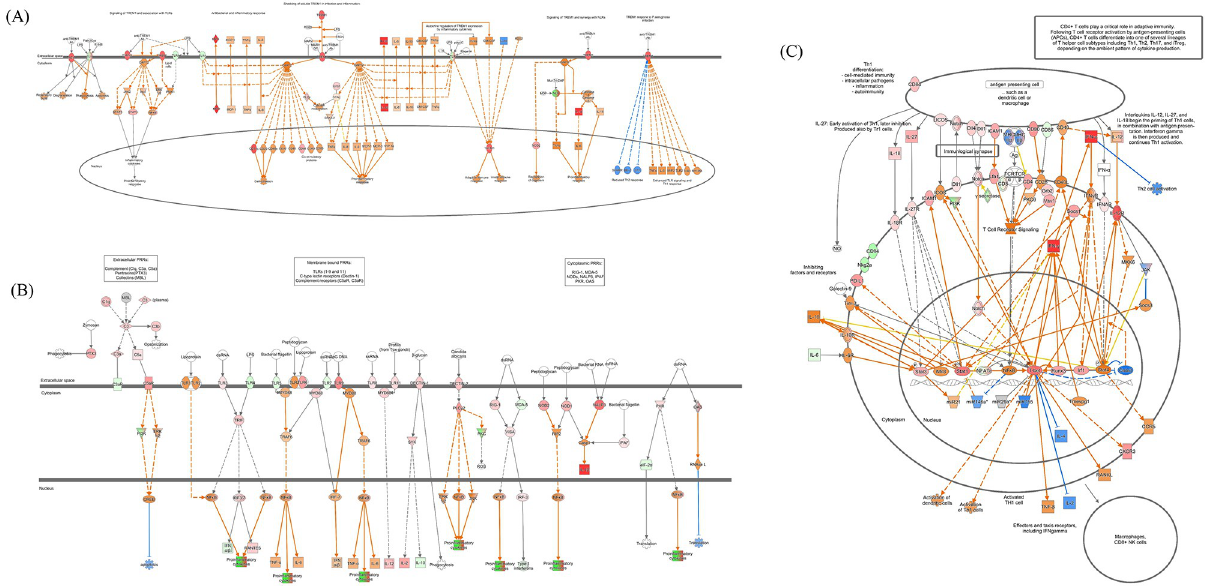
Fig 6. Ingenuity pathway analyses. TREM-1 signaling (A), Role of Pattern Recognition Receptors in Recognition of Bacteria and Viruses (B) and Th1 Pathway (C) in the MLN of the IP group at 6 weeks PI. Nodes are colored based on gene expression along with predictions of upstream and downstream molecules. A gene in red indicates upregulation, a gene in green indicates downregulation, a gene in orange indicates predicted activation, and a gene in blue indicates predicted inhibition. Uncolored nodes indicate that genes were not differentially expressed in the pathway shown.